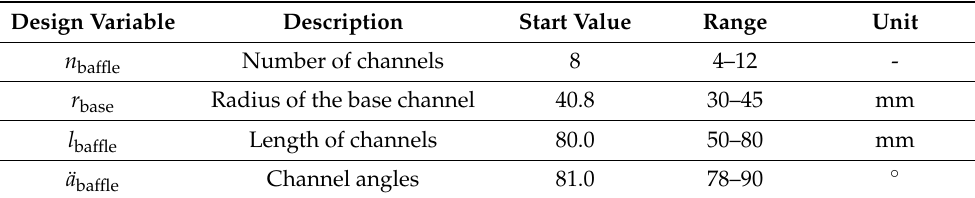
Figure 8. Graphical representation of the design variables for the optimization of the conventional cooling system. Table 3. Design variables for the optimization of the conventional cooling system. Figure 7. CAD model of the mold core ( left ), initial cooling system ( middle ), channel axes ( right ).